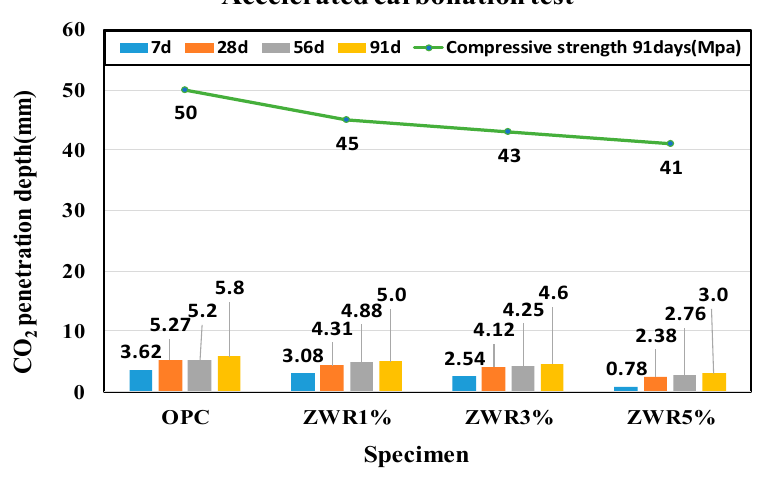
Figure 14. Graph of accelerated carbonation test.